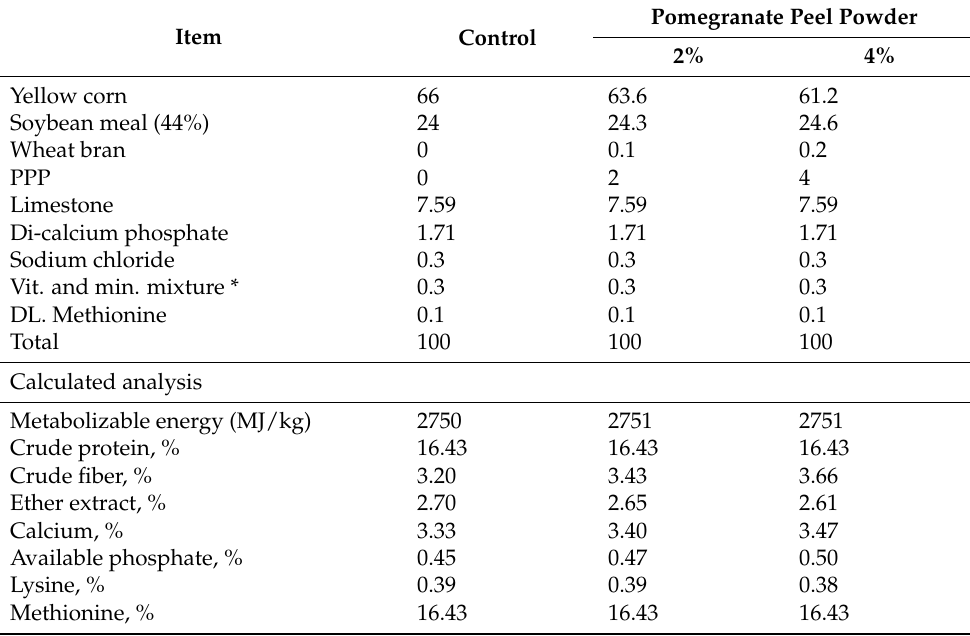
Table 1. Composition and calculated chemical analysis of the basal experimental